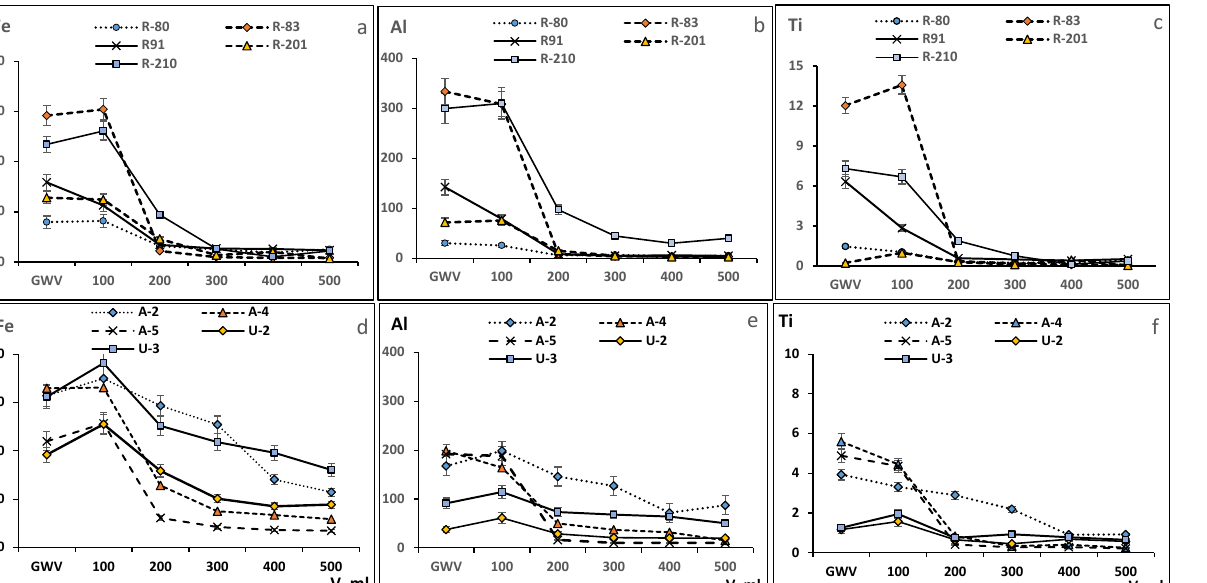
Figure 4. The concentrations of Y ( a , d ), Ce ( b , e ), and Dy ( c , f ) (µg/L) in filtrates obtained at the cap- sules (GWV) after 500 mL and Millipore membranes after filtration of 100, 200, 300, 400, 500 mL for waters from Razdolnaya R. (upper panel) and Amur R./Ussuri R. (lower panel).